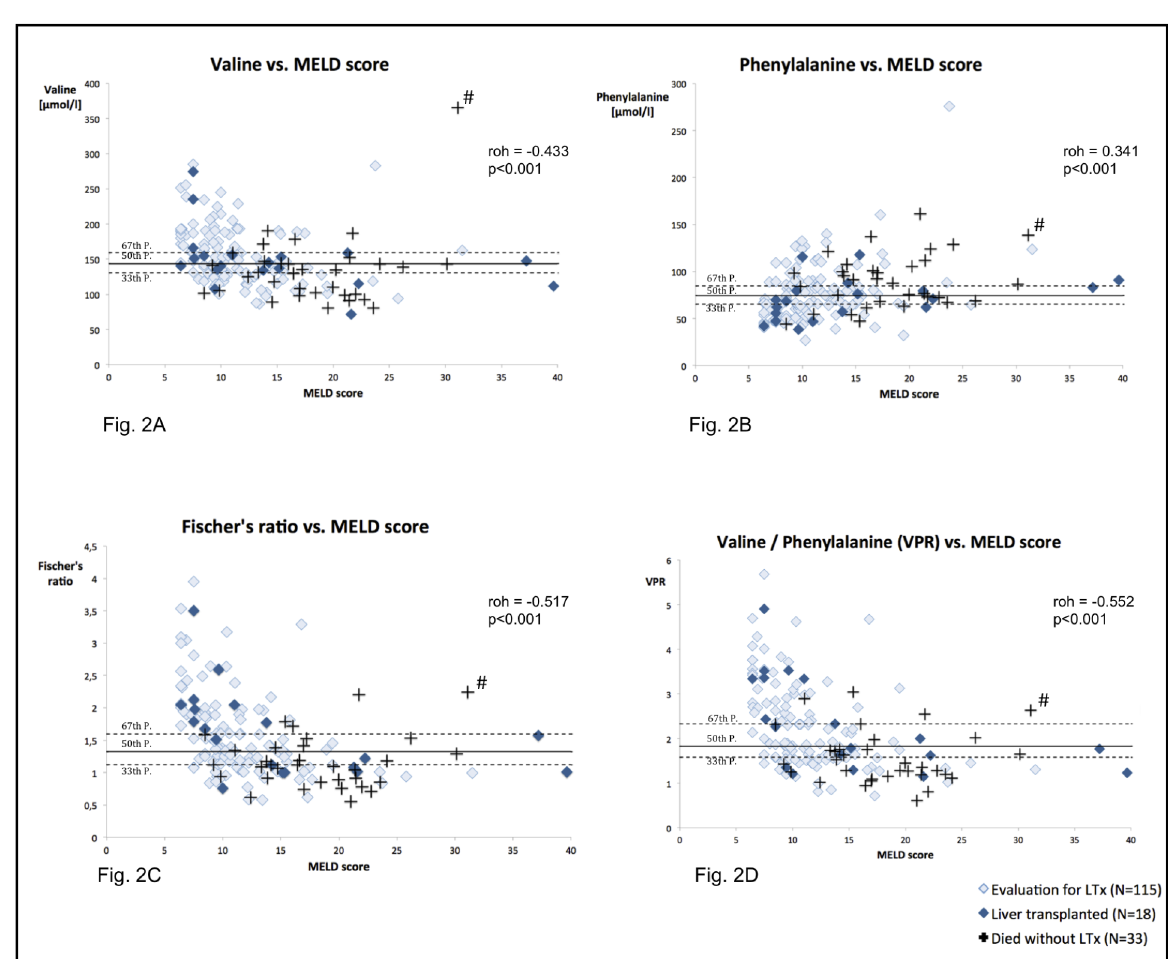
Fig 2. Correlation diagrams for chosen metabolites versus unrounded MELD scores (N = 166). LTx: liver transplantation. roh: Spearman ’ s roh coefficient. #: Patient who received Fresubin 1 Hepa before blood taking at Intensive Care Unit.